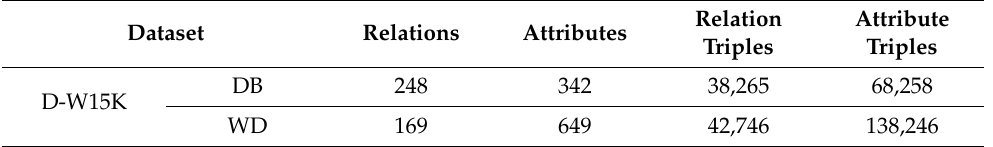
Table 1. Data statistics of the monolingual datasets.